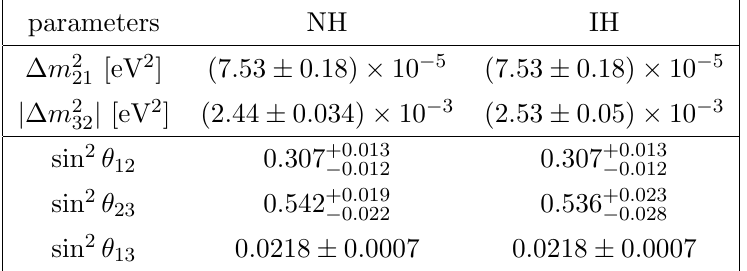
Table 1. The 1 (cid:27) values of the neutrino mass square di(cid:11)erences and mixing angles for NH and IH used in our numerical analysis